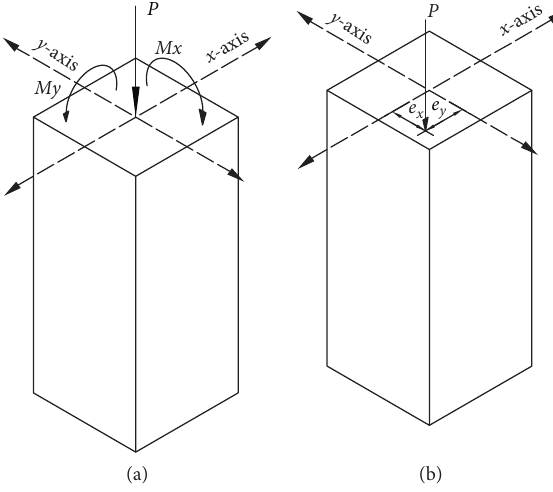
Figure 2: Eccentrically loaded column.